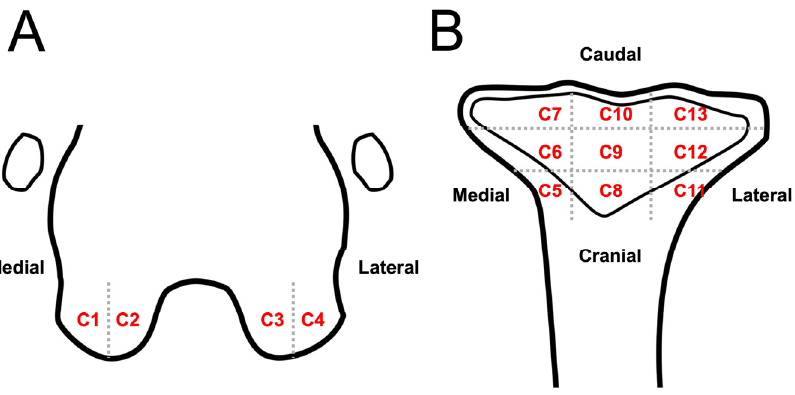
Figure 4. Schematic representation of stifle joint anatomic compartment subregions to evaluate cartilage lesion on MRI images: dorsal plane of the distal femur ( A ) and proximal tibia ( B ). Stifle joint is divided into 13 anatomic subregions to evaluate cartilage lesions: lateral part (A, C1) and medial condyle medial (A, C2); lateral condyle medial (A, C3) and lateral part (A, C4); tibia plateau medial region cranial (B, C5), middle (B, C6), and caudal part (B, C7); tibia plateau middle region cranial (B, C8), middle (B, C9), and caudal part (B, C10); tibia plateau lateral region cranial (B, C11), middle (B, C12), and caudal part (B, C13).